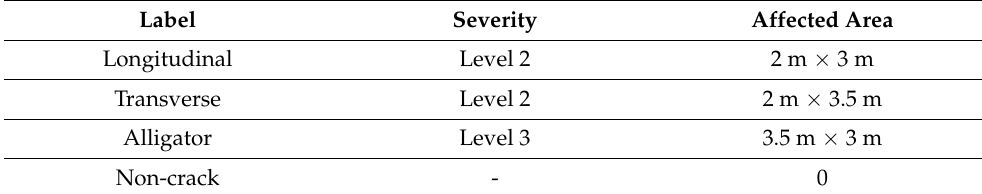
Table 5. Criteria for assigning crack severity labels according to the crack type.